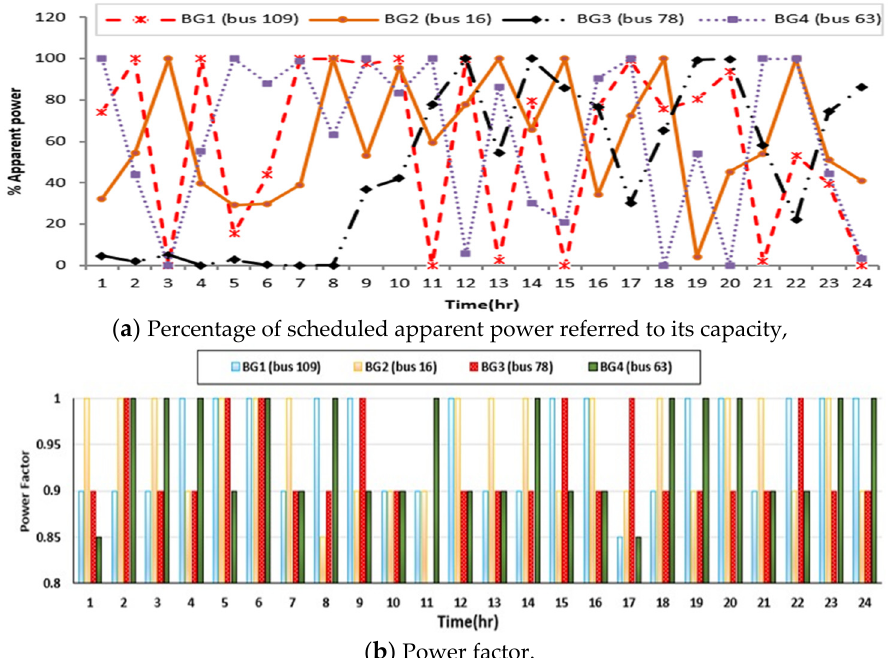
Figure 19. Hourly apparent power and power factor of each BG for case 3 for the second MG.